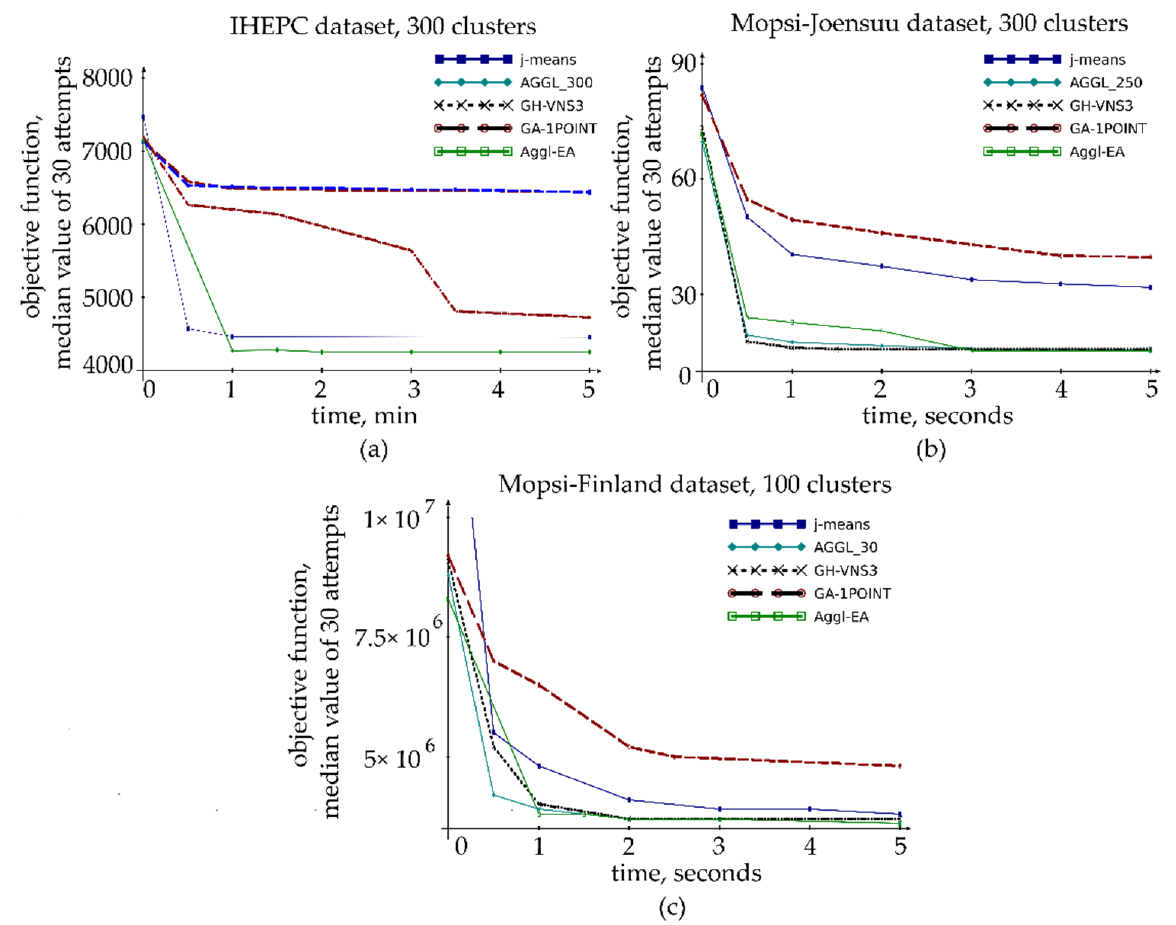
Figure 3. Comparative analysis of the convergence speed. Dependence of the median result on computation time for: ( a ) Individual Household Electric Power Consumption (IHEPC) dataset, 50 centers, 2,075,259 data vectors, time limitation 300 s; ( b ) Mopsi-Joensuu dataset, search for 300 centers, 6014 data vectors, time limitation 5 s. ( c ) Mopsi-Finland dataset, search for 300 centers, 13,467 data vectors, time limitation 5 s.